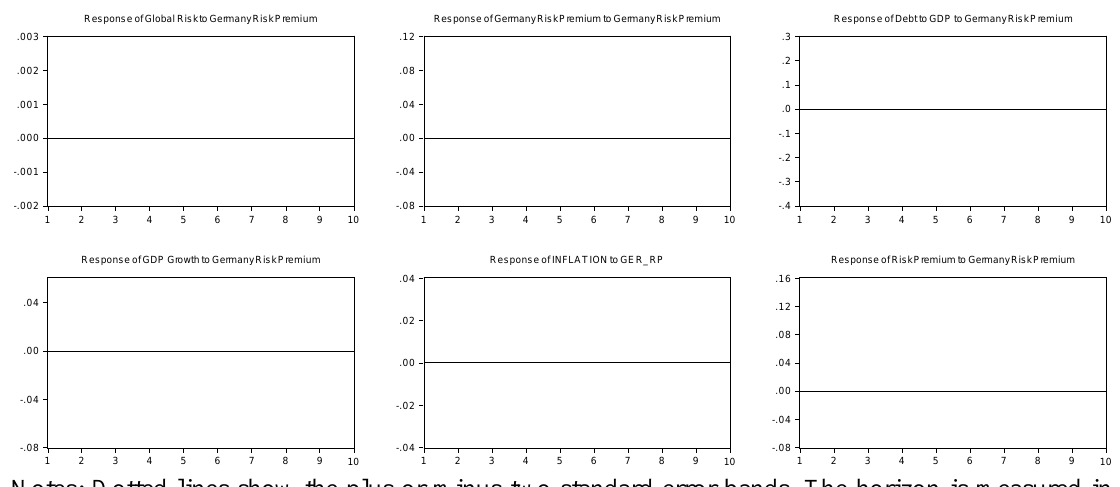
Notes: Dotted lines show the plus or minus two-standard error bands. The horizon is measured in quarters. See the notes to previous figures for additional